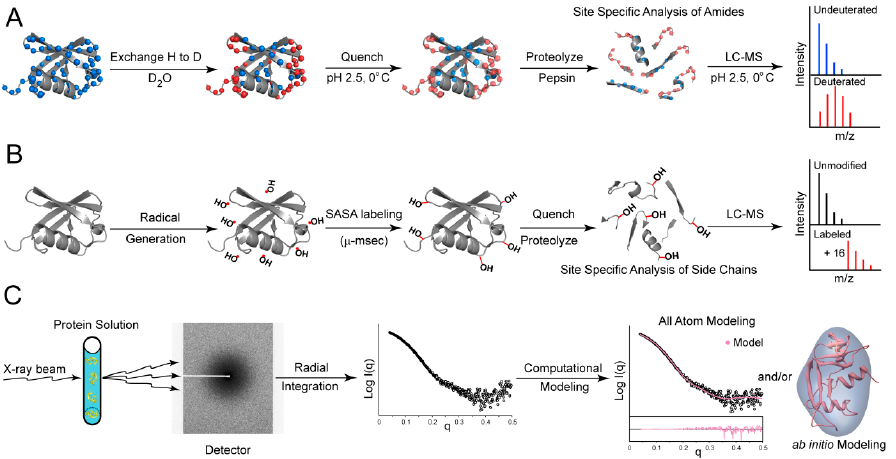
Figure 2. Solution Based Approaches for Protein Characterization ( A ) Hydrogen-Deuterium Exchange Mass Spectrometry (HDX-MS). Exchange of backbone amide protons for deuterons is initiation by incubating a protein in deuterated buffer for various amounts of time, reaction is quenched at pH 2.5 and on ice, samples are denatured and digested, and mass shifts are analyzed by mass spectrometry; ( B ) Oxidative Labeling MS. Biological macromolecules in solution are exposed to hydroxyl radicals for various periods of time, which covalently modify solvent accessible surface area (SASA) via amino acid side chains. Radicals can be rapidly generated by radiolysis of water or photolysis of hydrogen peroxide, or slowly generated using Fenton’s reagents. The reaction is quenched using radical scavengers and the samples are proteolyzed and analyzed by mass spectrometry; ( C ) Small Angle X-ray Scattering (SAXS). Biological macromolecules in solution are irradiated with a monochromatic X-ray beam, which generate a characteristic scattering pattern. Computational methods such as all-atom modeling can be used to compare high-resolution structures to the solution-phase data, or ab initio shape reconstruction can be used to generate low-resolution morphological